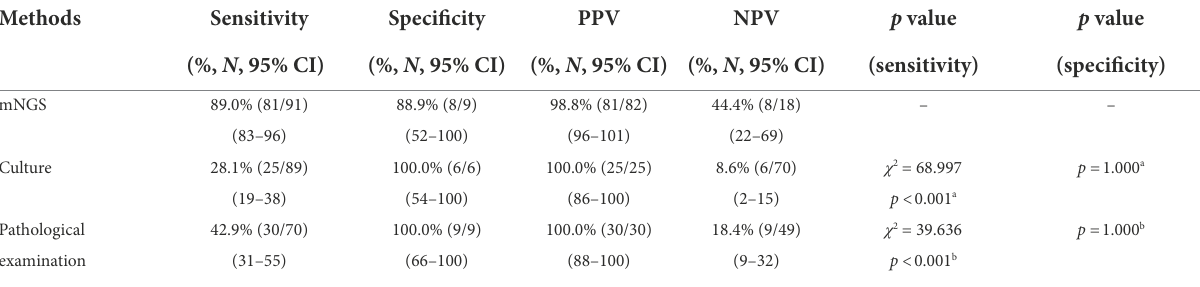
TABLE 2 Performance of mNGS and conventional detection methods in patients with spinal